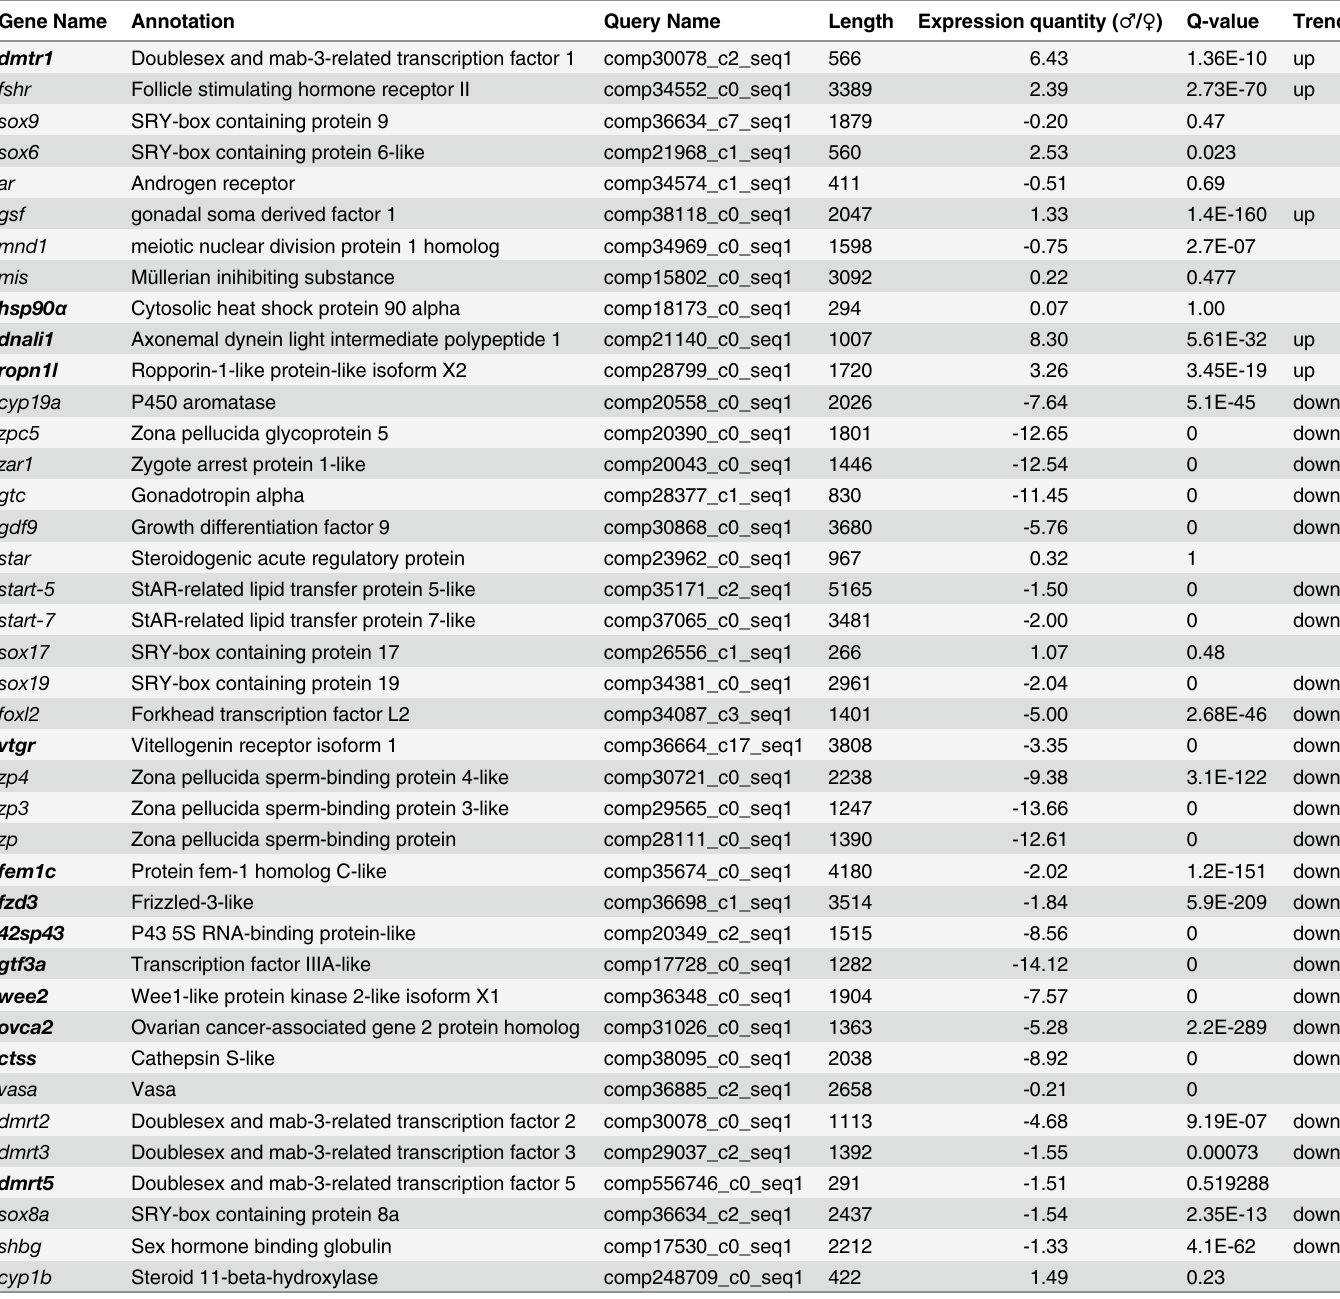
Table 2. Identified genes involved in sex determination and development in the present turbot